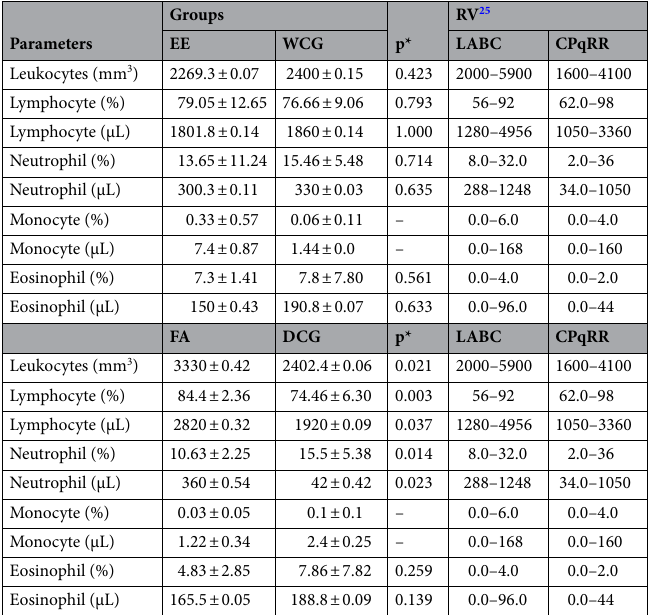
Table 3. Leukogram of mice treated with ethanolic extract or alkaloid fraction from Aspidosperma nitidum. EE ethanolic extract, FA fraction of alkaloids, WCG water control group, DCG DMSO control group (99%